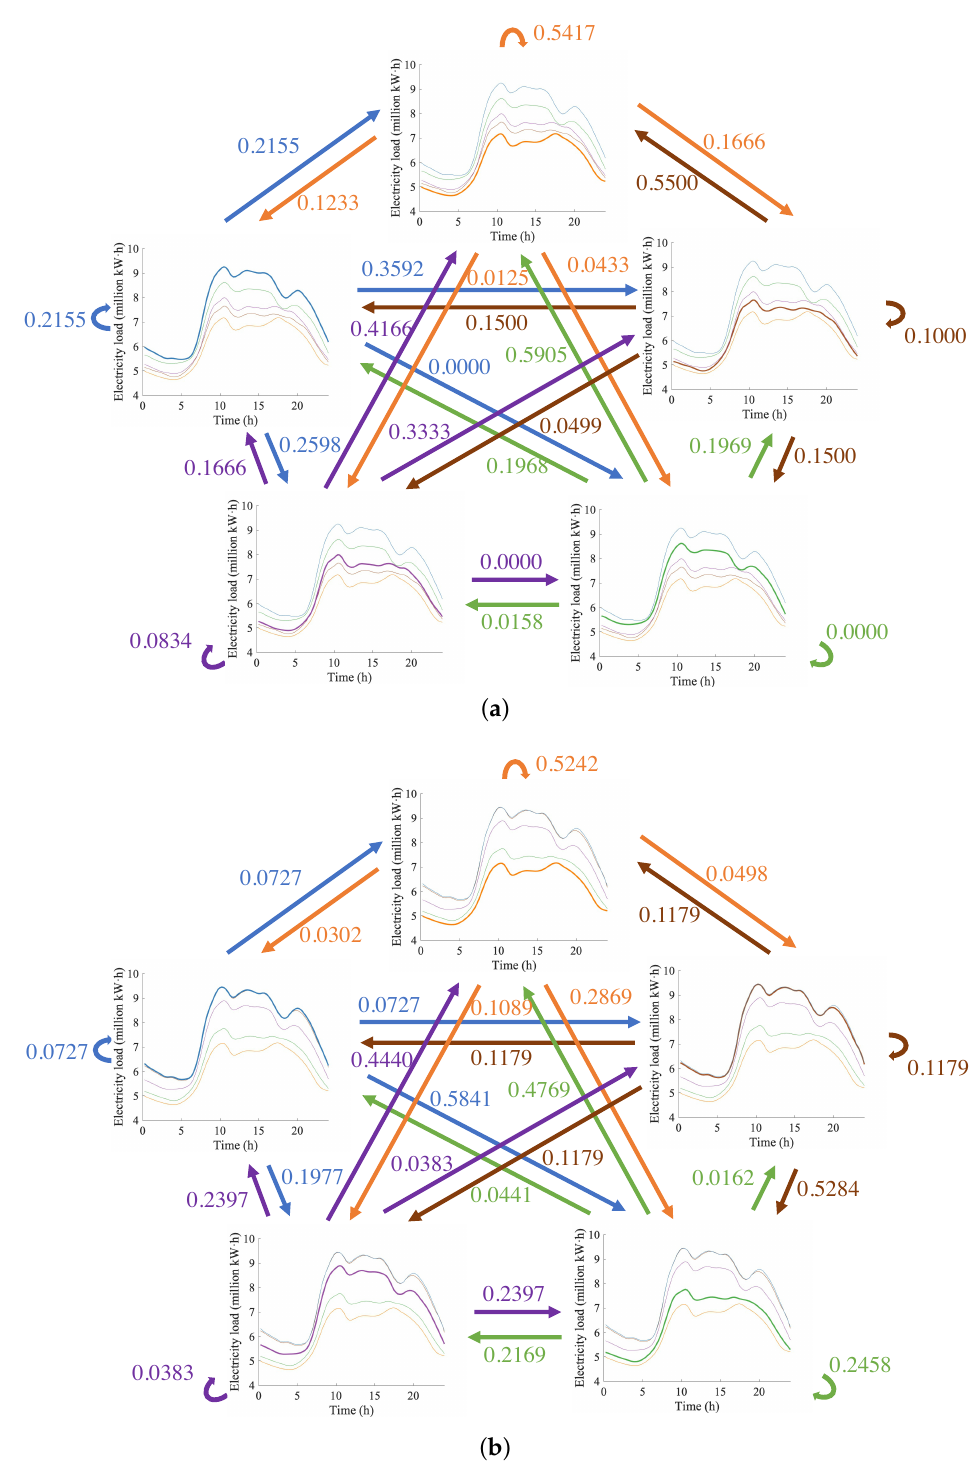
Figure 3. Evolving law of electricity loads and transition dynamics learned by HM-GPFR ( a ) and BHM-GPFR ( b